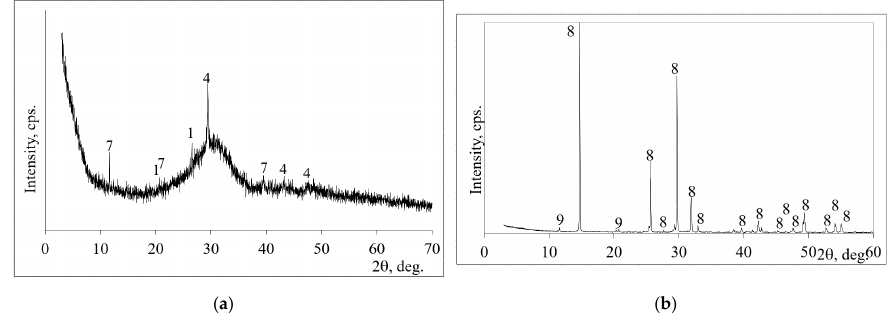
Figure 3. X-Ray diffraction patterns of GGBFS ( a ) and phosphogypsum ( b ). Indices: 1 is quartz (78–2315), 4 is calcite (83–578), 7 is indicates hydrotalcite (14–191), 8 is basanite (33–310), and 9 is brushite (11–293).